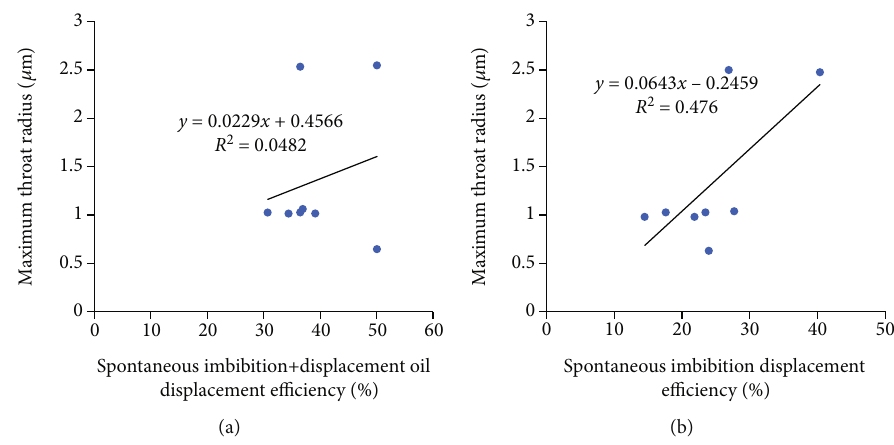
Figure 7: Correlation between oil displacement e ffi ciency and maximum pore throat radius.